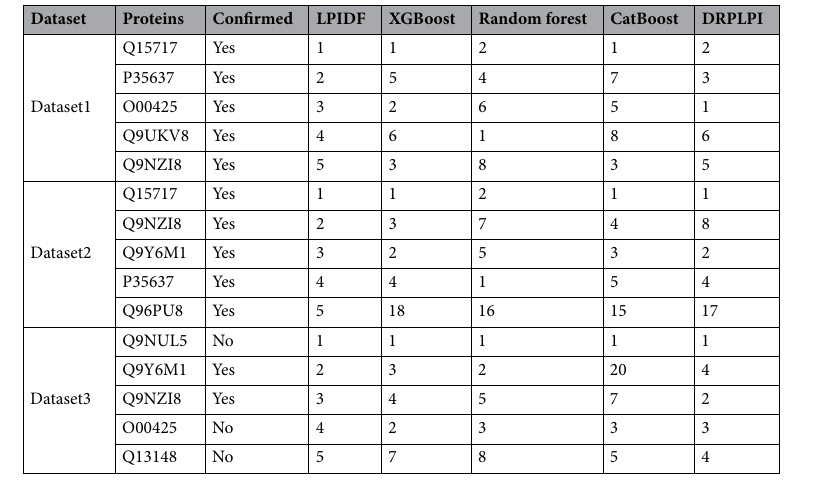
Table 4. The predicted top 5 proteins interacting with SNHG3.